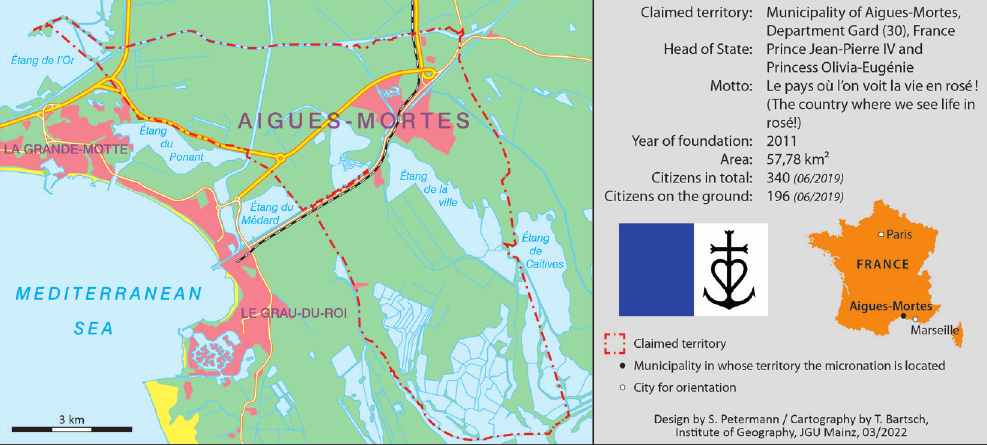
225 www.img-network.it